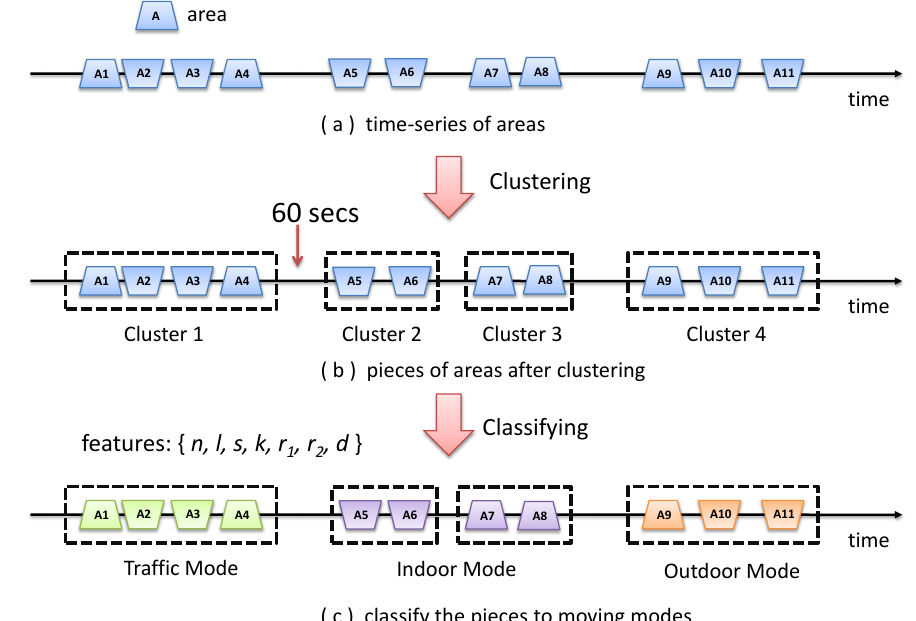
Figure 7. Overview of moving mode